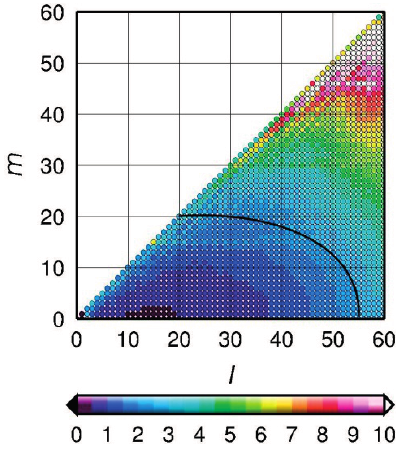
Figure 3. Error (scaled by ×10 − 12 ) in degree l and order m of residual spherical harmonic coefficients for empirically determining the boundary for keeping low degree of SHCs portion unchanged in the decorrelation processing ( i.e. , the black